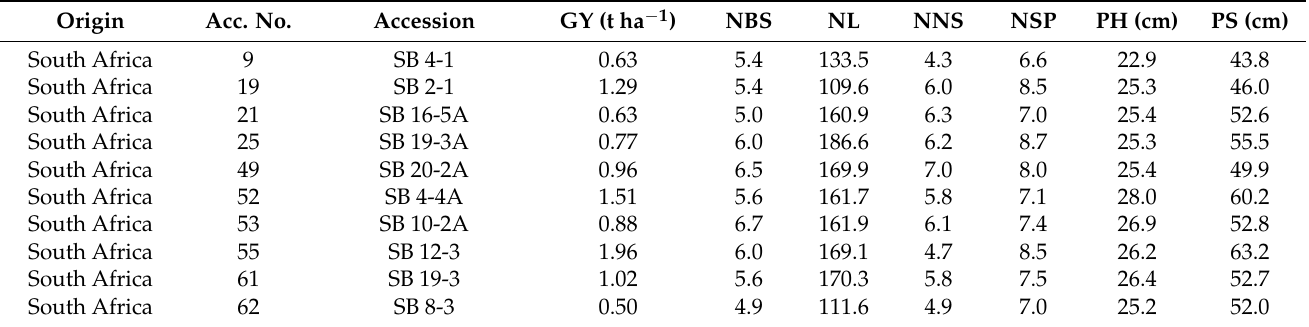
Table 5. Means of grain yield and yield components of bambara groundnut accessions from combined analysis of accessions planted at Vaalharts in 2016–2017 and 2017–2018 and at Roodeplaat during the 2016–2017 cropping